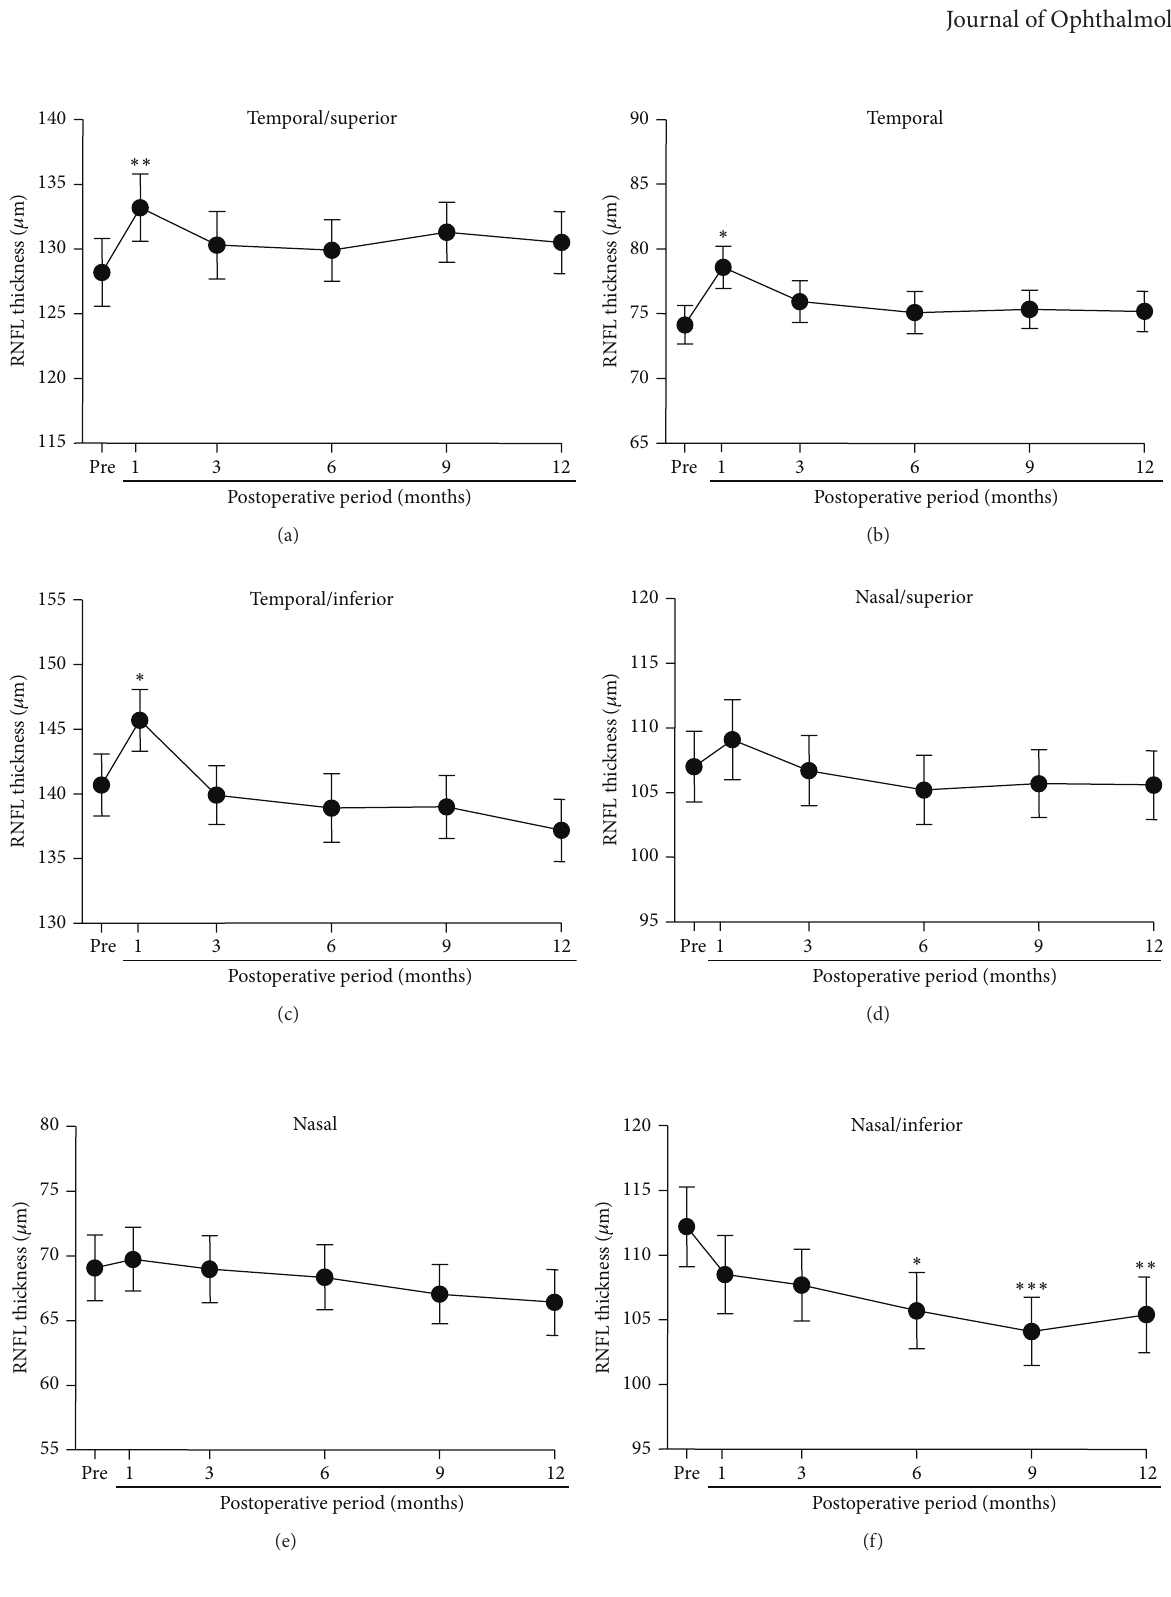
Figure 5: The means of the absolute RNFL thickness are plotted as a function of the postoperative periods for the superior/temporal (a), temporal (b), inferior/temporal (c), inferior/nasal (d), nasal (e), and superior/nasal (f) sector analysis. Mean ± SEM. RNFL: retinal nerve fiber layer, ∗ 𝑃 < 0.01 , ∗∗ 𝑃 < 0.001 , ∗∗ 𝑃 < 0.0001